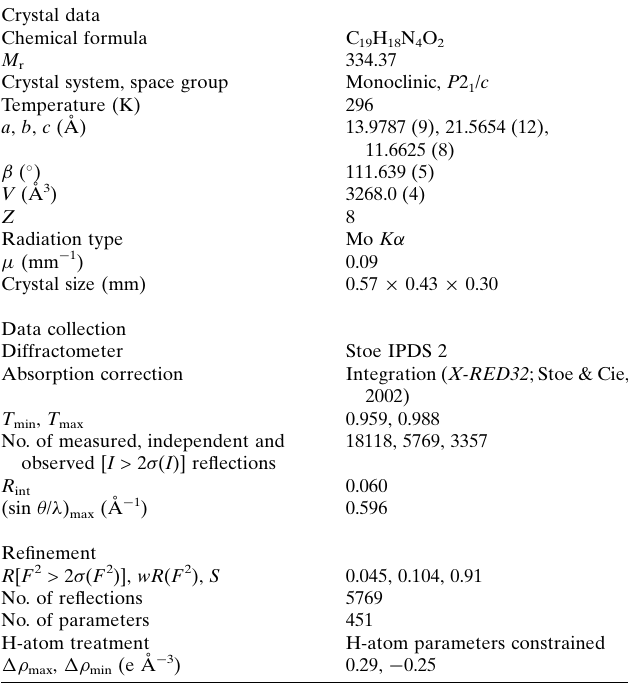
Table 2 Experimental